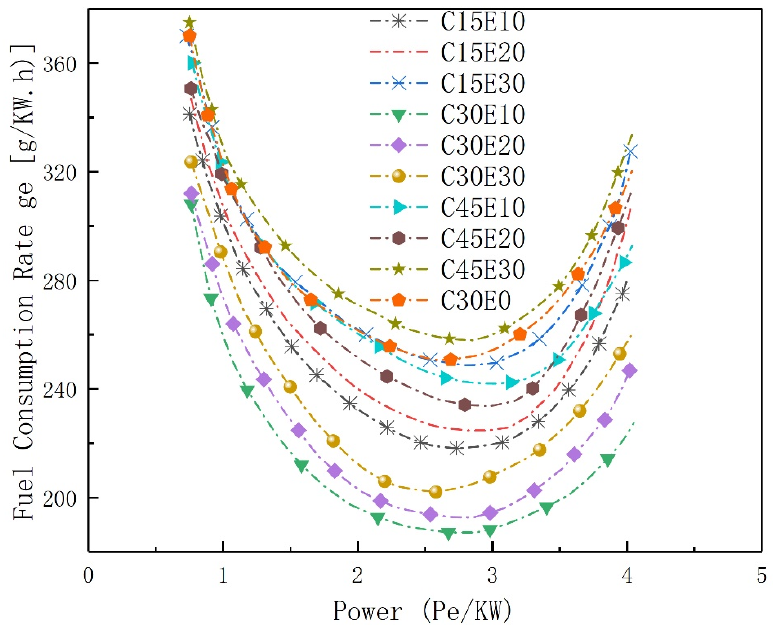
Figure 8. Load characteristics of all swirl chamber diesel engine schemes at the rotation speed of 1800 r/min. Note: the scheme numbers are the same as those in Table 1.